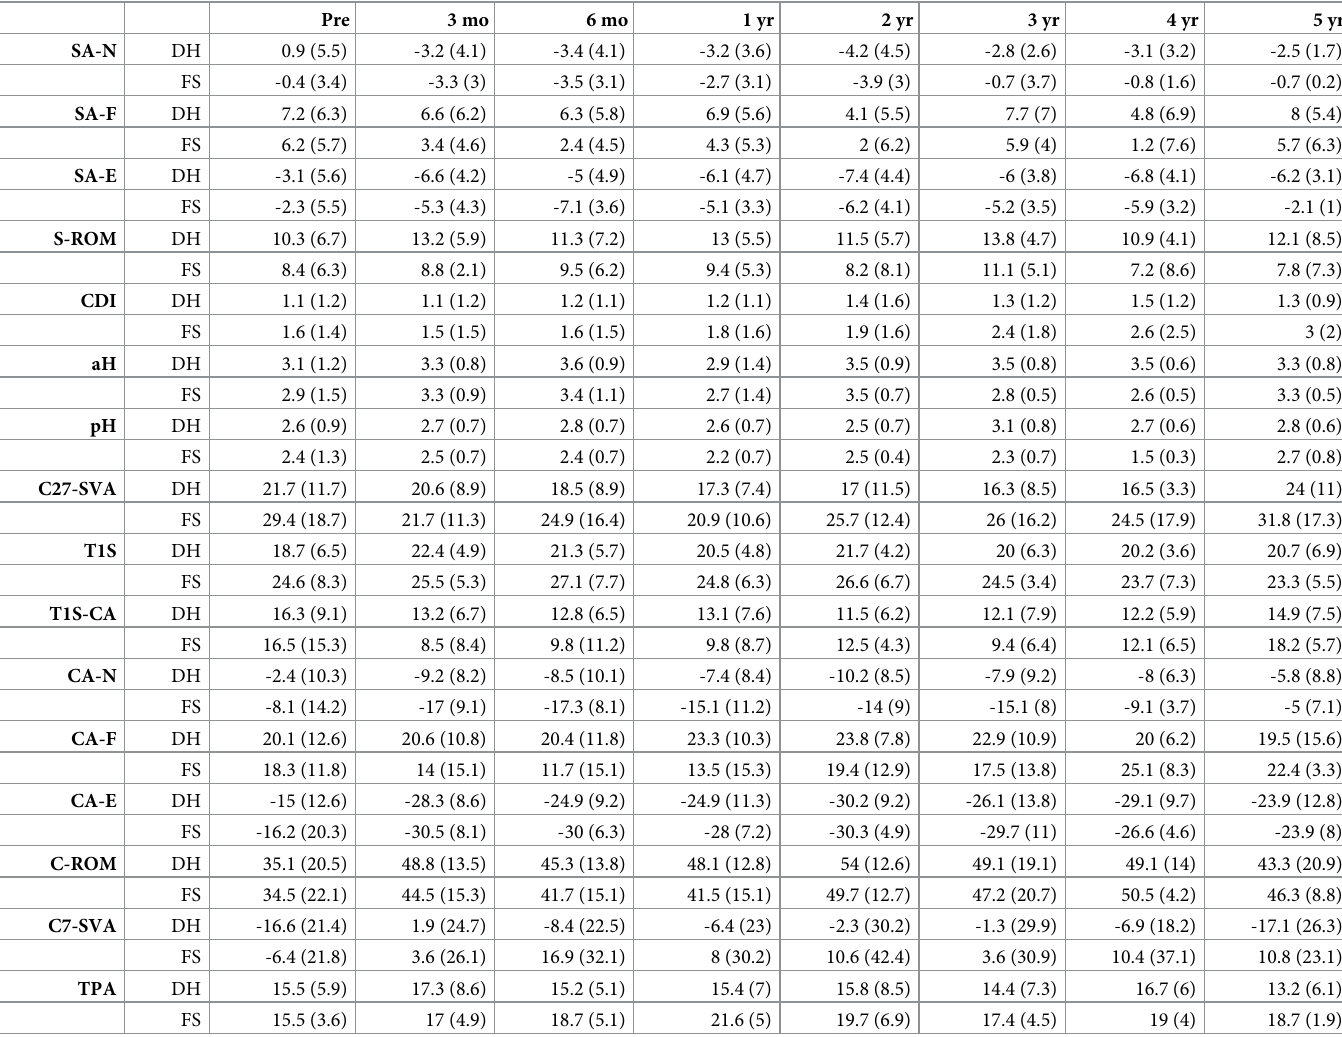
Table 3. Radiological outcomes: Adjusted mean (standard deviation) �